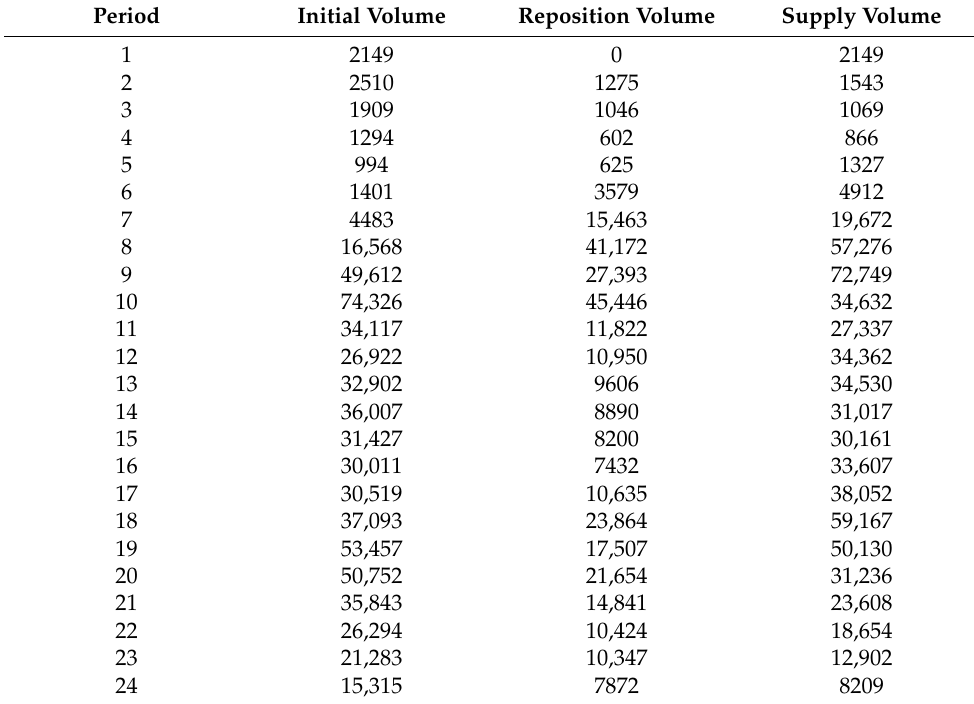
Table 3. Reposition and supply volumes of shared bikes.